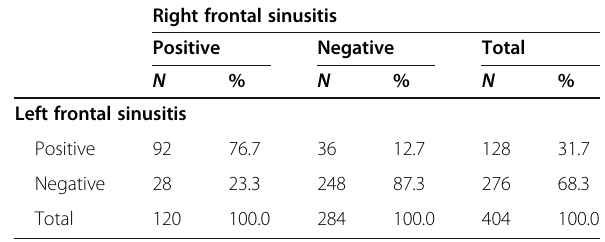
Table 3 Comparison of the right and left sides in terms of the frequency of frontal sinusitis